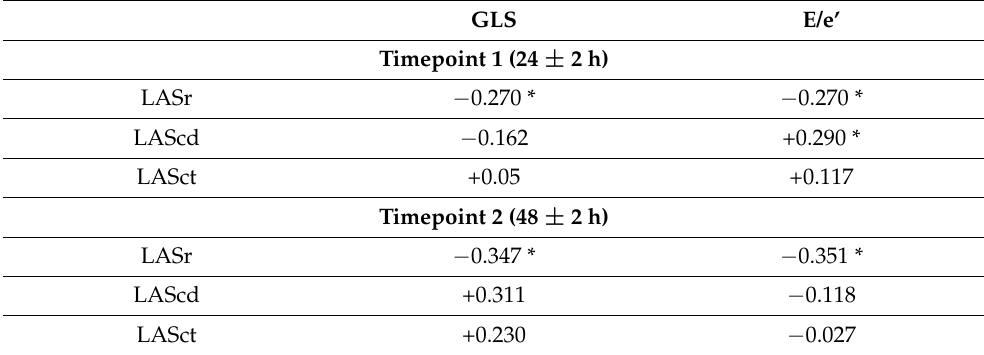
Table 7. Correlations between LASr, LAScd, LASct and other echocardiographic parameters at 24 and 48 h in the second cohort of